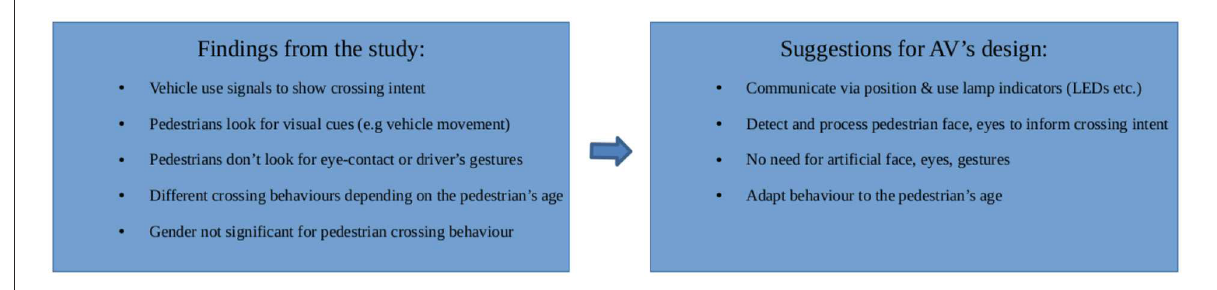
FIGURE10 Main findings and suggestions for AV designers from the sequence patterns analysis (Camara et al.,